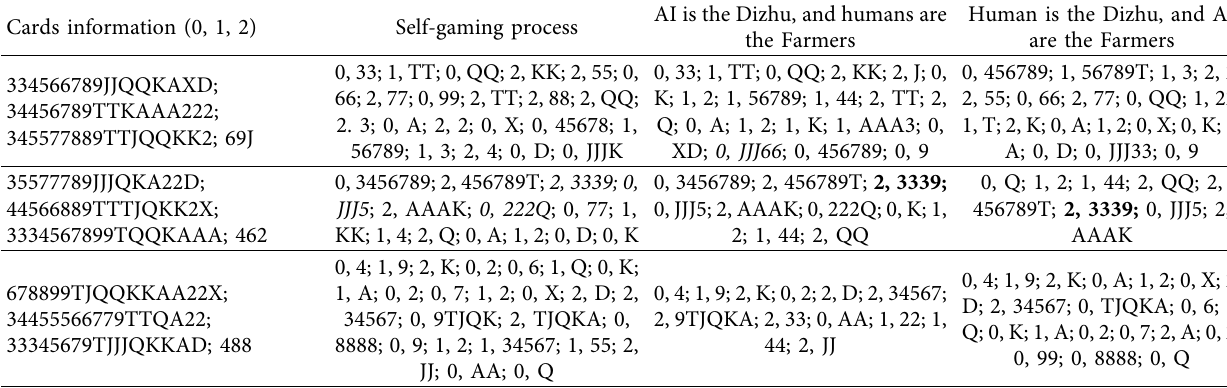
Table 3: Game flow.